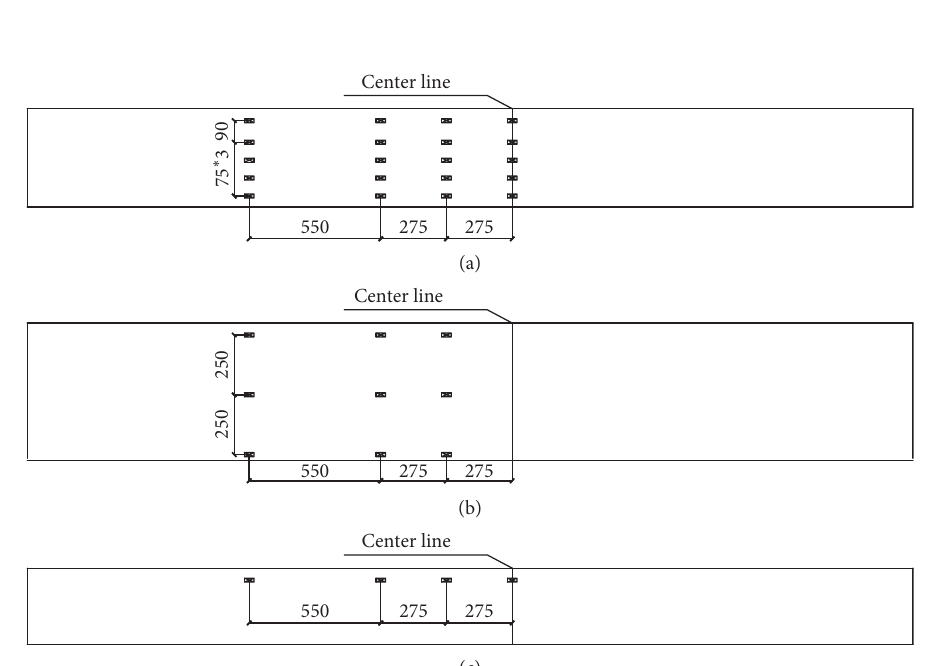
Figure 11: Layout of measuring points of steel beam (unit: mm). (a) Layout of inner and outer webs. (b) Layout of outside of base plate. (c) Layout of lower side of upper